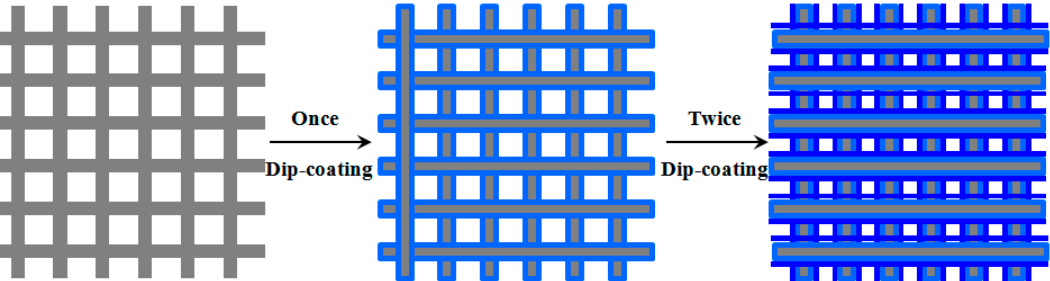
Figure 1. Schematic of preparation of superhydrophilic and underwater superoleophobic composite membrane via a two-step coating method.